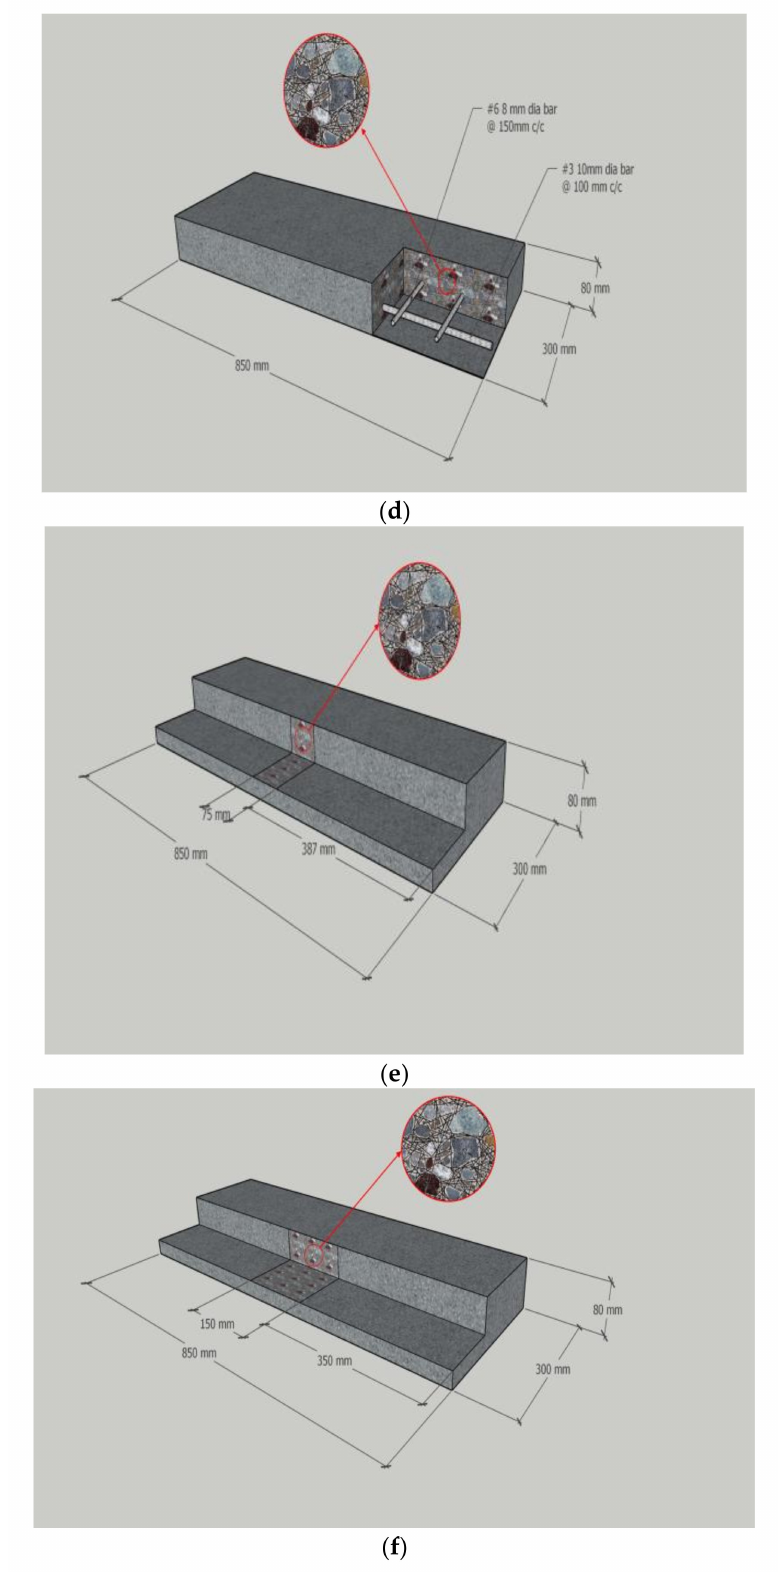
Figure 3. Schematic representation of different types of slabs. ( a ) Reinforcement details of